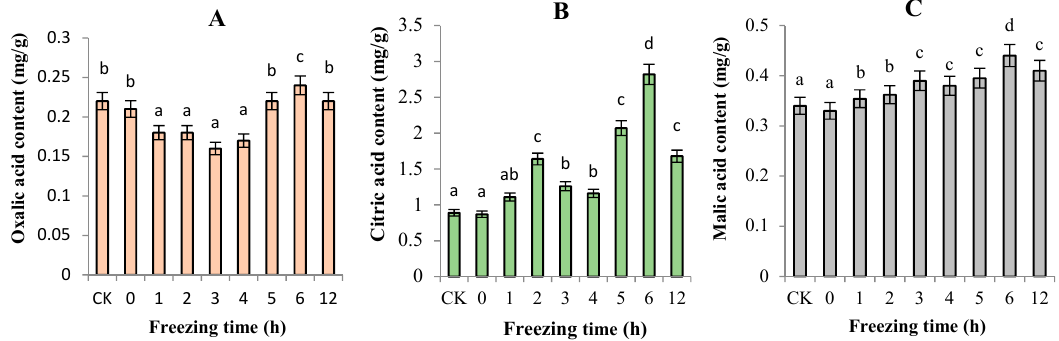
Figure 8. Changes in organic acid ( A : oxalic acid, B : citric acid, C : malic acid) content in “Ruaner” pear during the freezing–thawing stage. Different letters indicated significant differences between thawing time treated and control (Duncan’s multiple range test, p < 0.05).